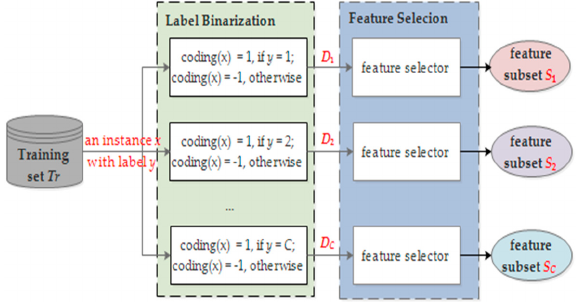
Figure 3. The proposed class dependent feature selection method. For a C -class problem, C